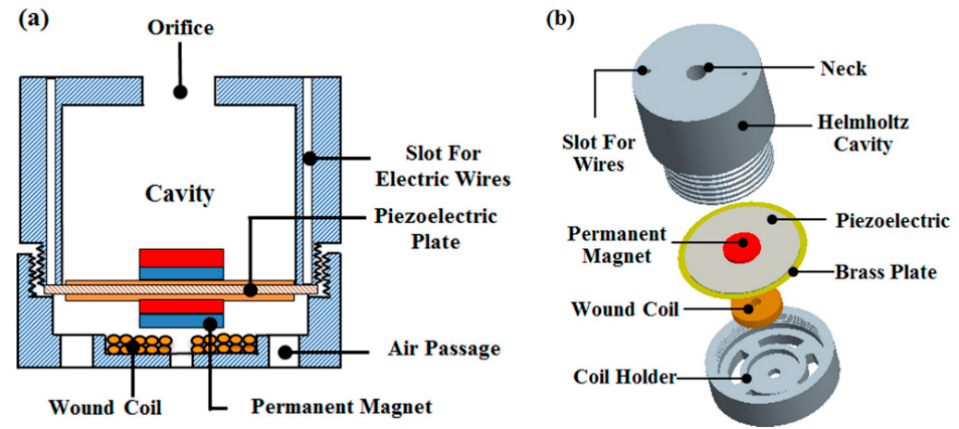
Figure 8. Schematic diagram of the hybrid AEH device, which is based on the Helmholtz resonator and integrates piezoelectric and electromagnetic conversion. ( a ) Cross-section view; ( b ) exploded view. Reproduced with permission from [39]; published by American Institute of Physics, 2016.